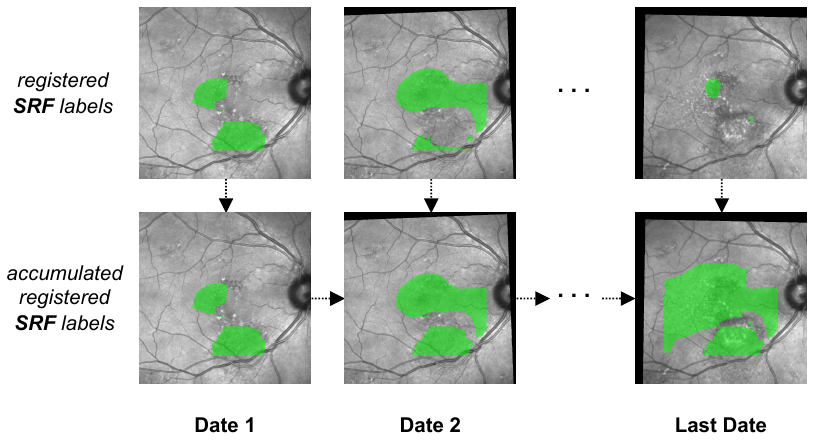
Figure 8. The process of generating accumulated SRF labels ( bottom row) from single SRF labels ( top row) over multiple dates. In the accumulated SRF labels, each pixel that at some point up to the current date had been observed as being occupied by SRF is colored in green. The process is identical for HF